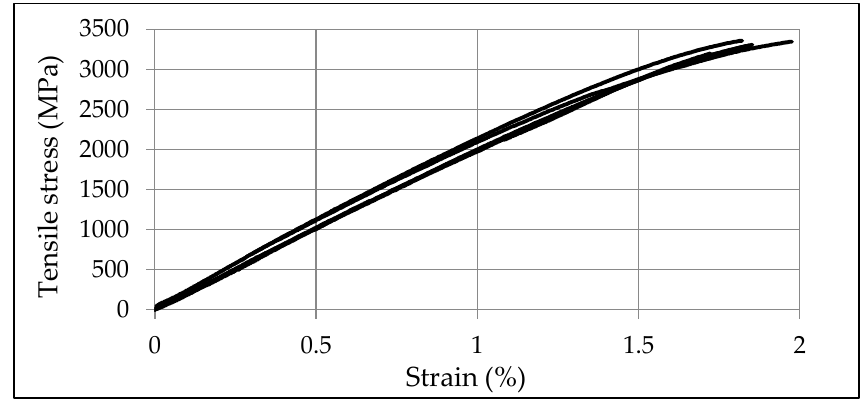
Figure 2. The stress–strain relationship for 3X2-20 steel textile.